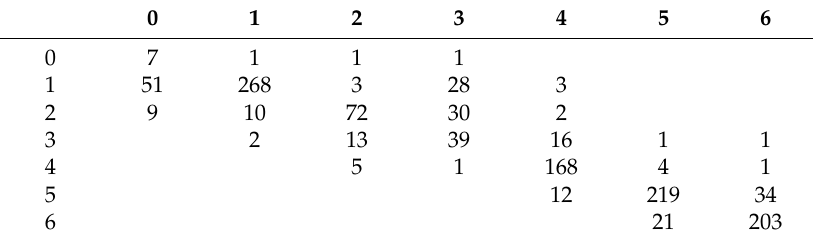
Table A2. The confusion matrix of Figure 9a.